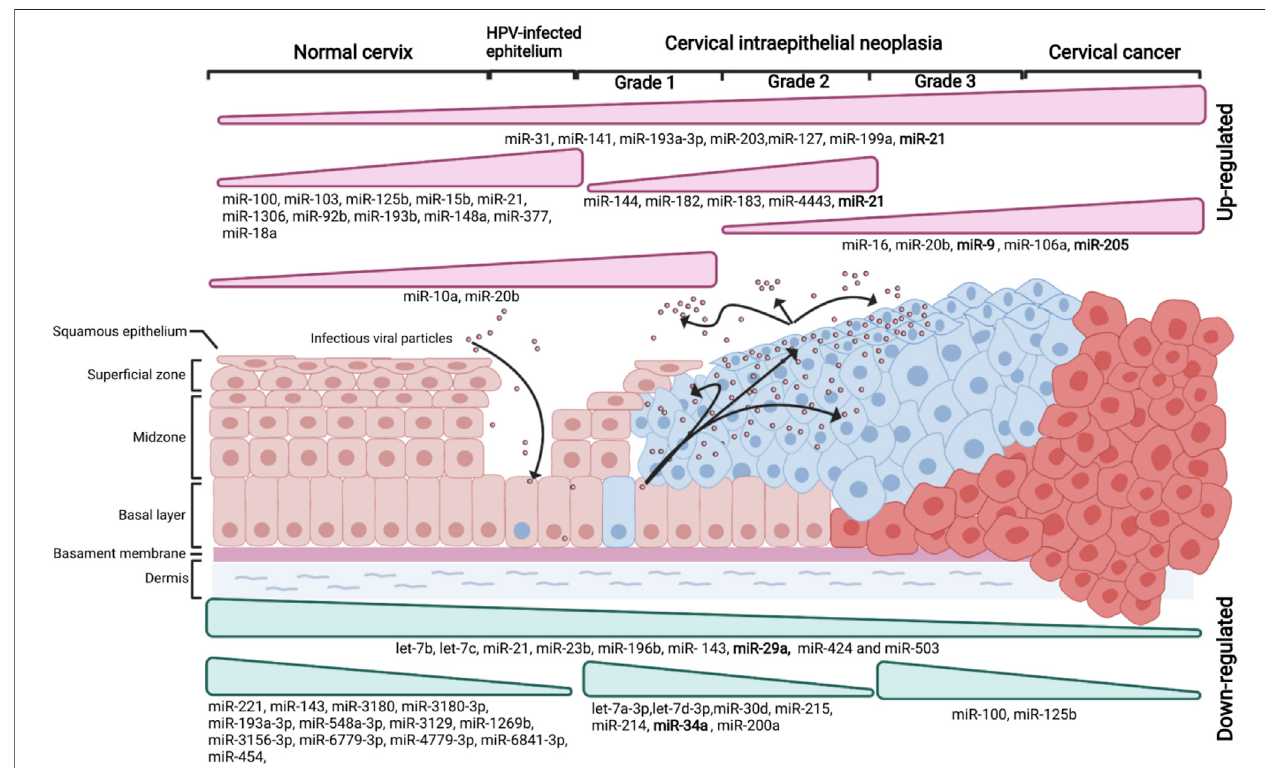
FIGURE 1 | Survey of dysregulated miRNAs in the different stages of cervical carcinogenesis (Created with BioRender.com). Variations in miRNA expression provide a signature of miRNAs in almost every stage of cervical cancer (CC) development. These miRNA signatures might be advantageous in the diagnosis and the monitoringofCC.Thenormalcervicalepitheliummorphologyisshownintheleftfollowedbyintraepitheliallesions(Grade1,Grade2,andGrade3)andCC.ThemiRNAs essential for the development and maintenance of CC with a diagnostic potential are shown in boldface.